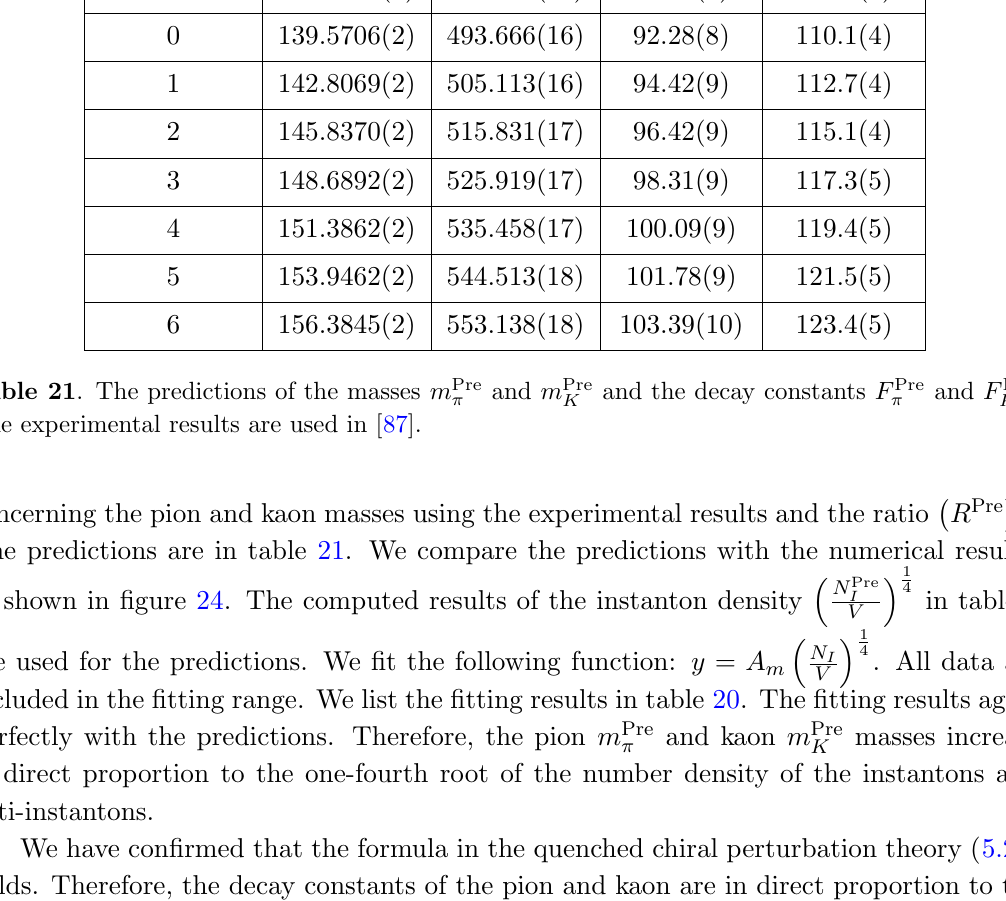
Table 21 . The predictions of the masses m Pre